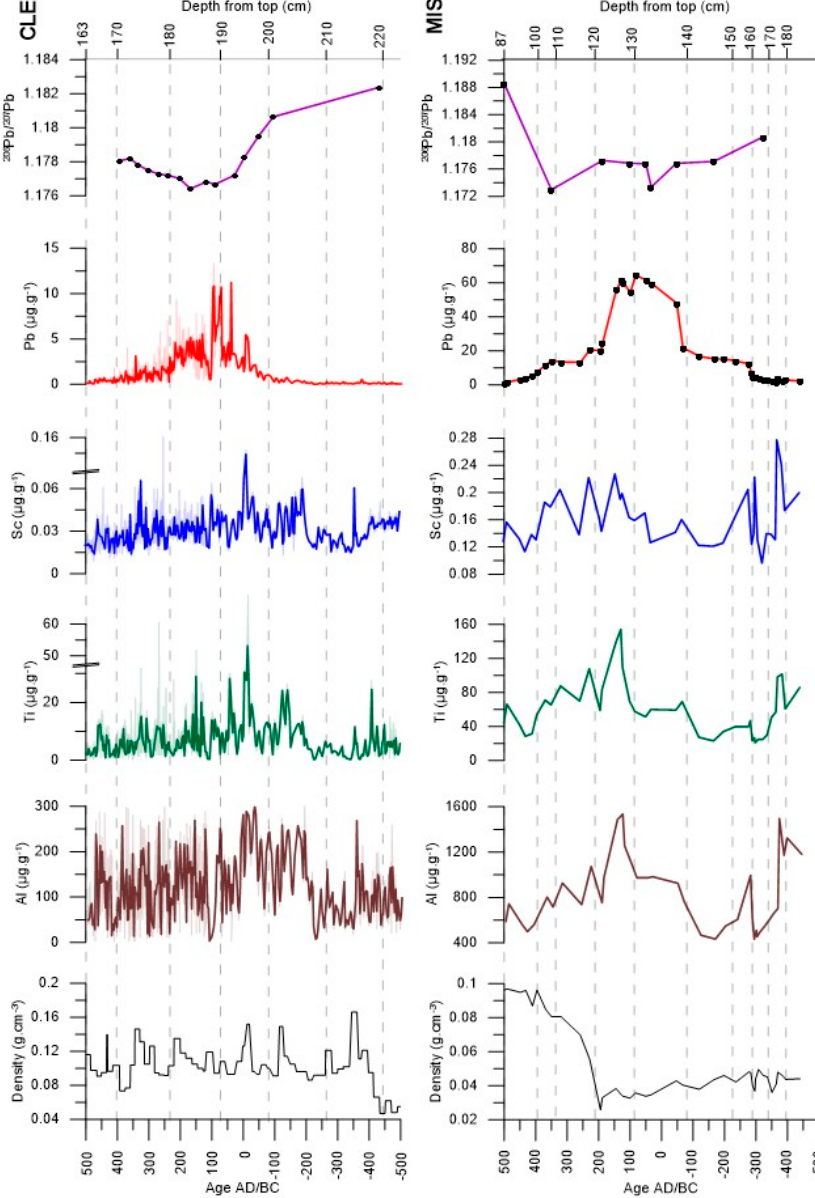
Figure 2. Evolution of density, elemental concentrations (Al, Ti, Sc and Pb), and radiogenic isotope 207 Pb/ 206 Pb ratios versus age and depth in CLE and MIS cores. Light lines indicate elemental concentrations and dark lines represent mean concentrations values.